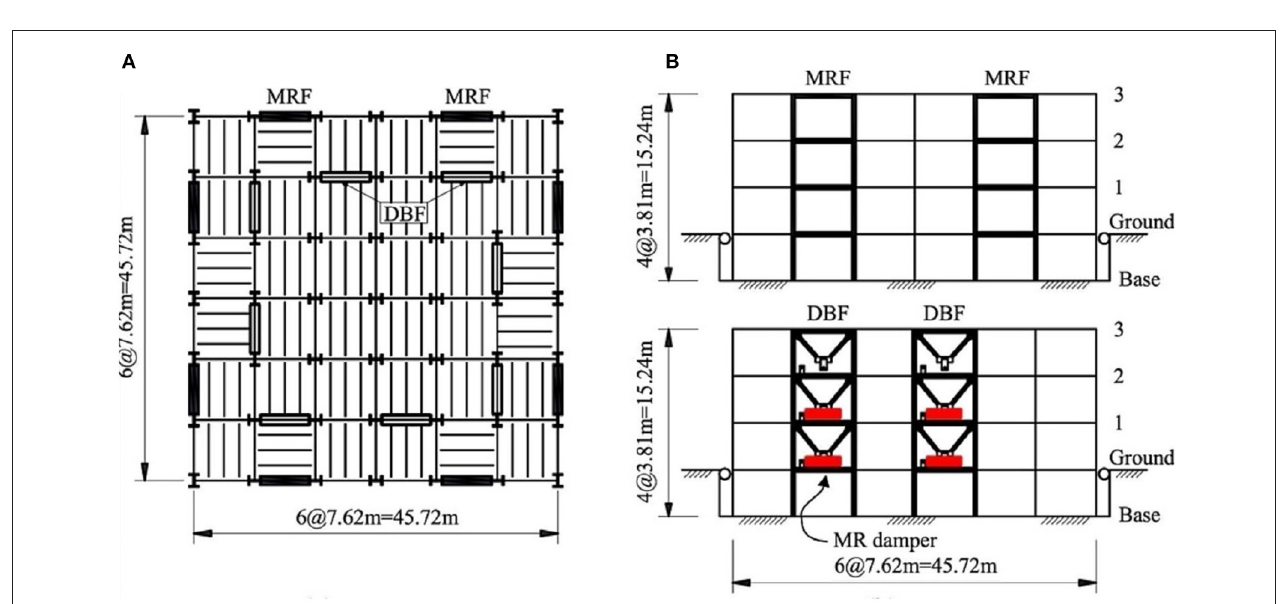
FIGURE 5 | Three-story building: (A) plan view and (B) elevation (reprinted from Chae et al., 2014 with permission).